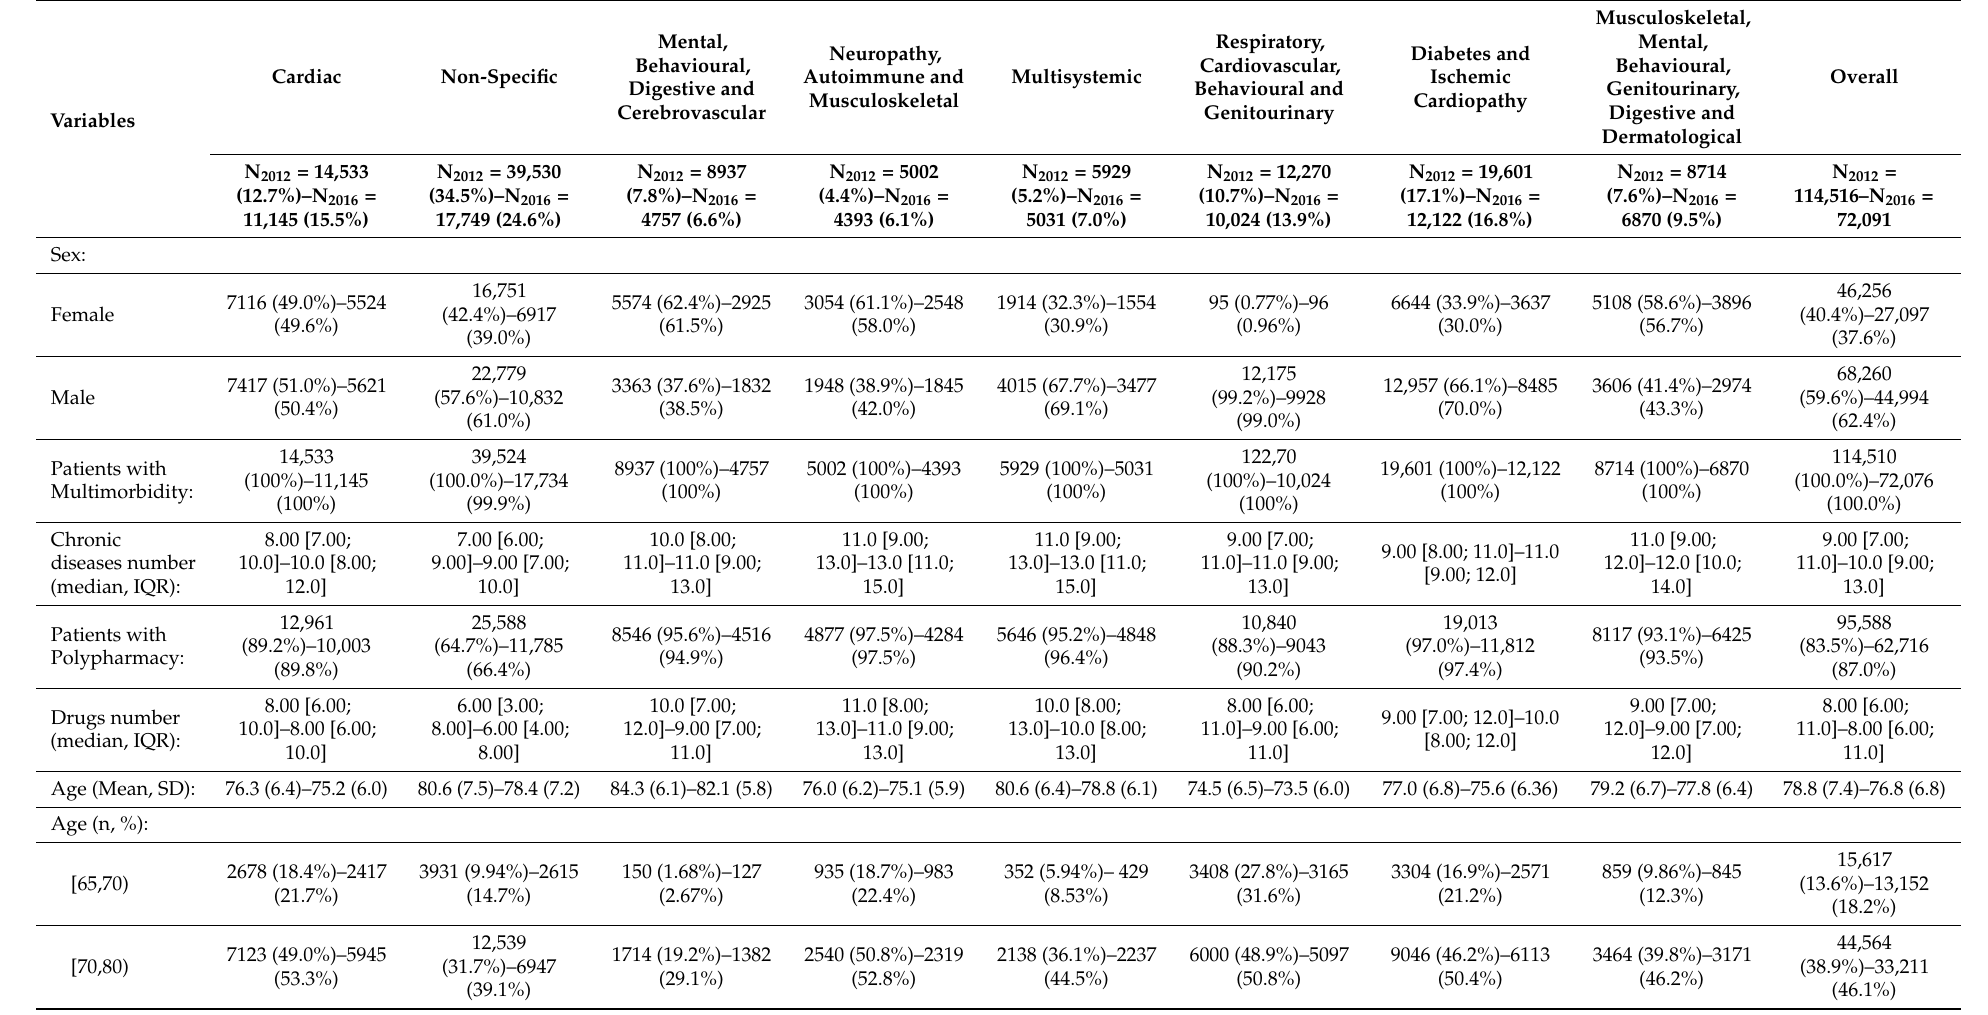
Table 1. Variables characterizing each cluster in the study at baseline and at the end of the study (N =